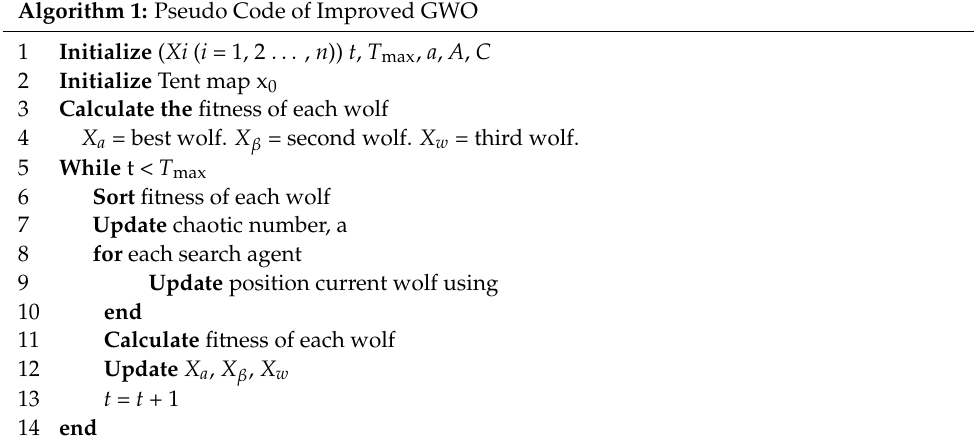
Algorithm 1: Pseudo Code of Improved